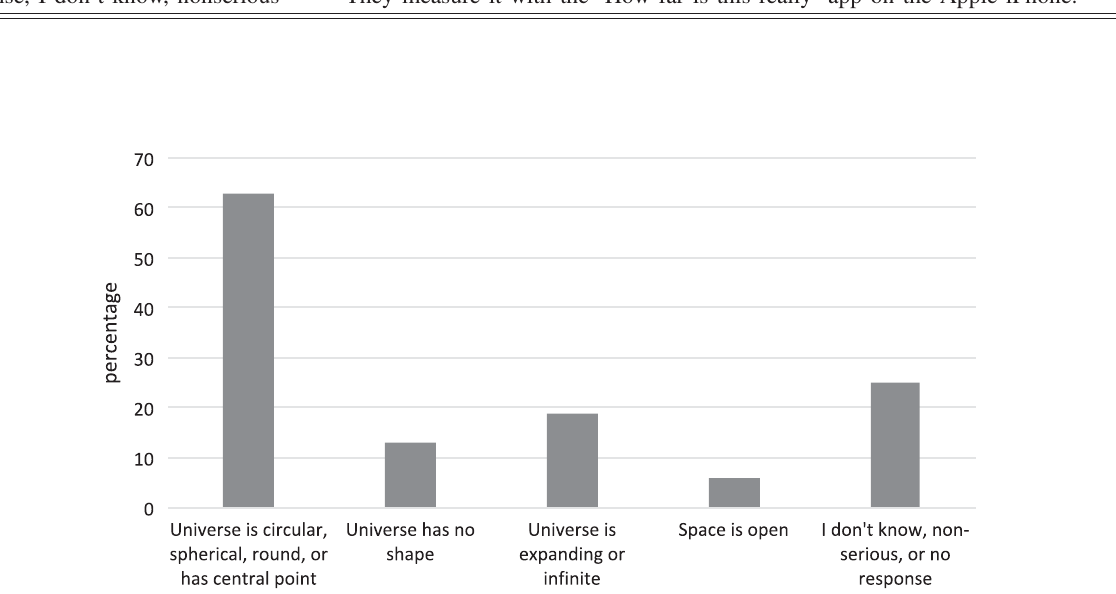
FIG. 3. ASTRO 101 preinstruction survey responses for What is the shape or geometry of the Universe? ( N ¼